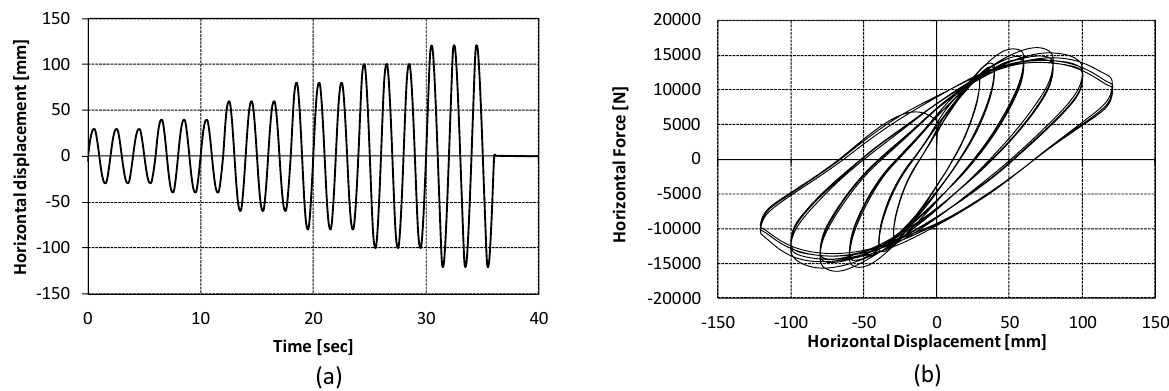
Figure 1. Setup of the experimental tests. The bearings were tested under displacement control by applying axial and lat- eral loads, simultaneously. In particular, cyclic shear tests were performed applying a constant vertical pressure (3.85 MPa) and imposing increasing horizontal deformations, ranging from 15% to 60%, at 0.5 Hz frequency. The imposed displacement history is shown in Figure 2a.